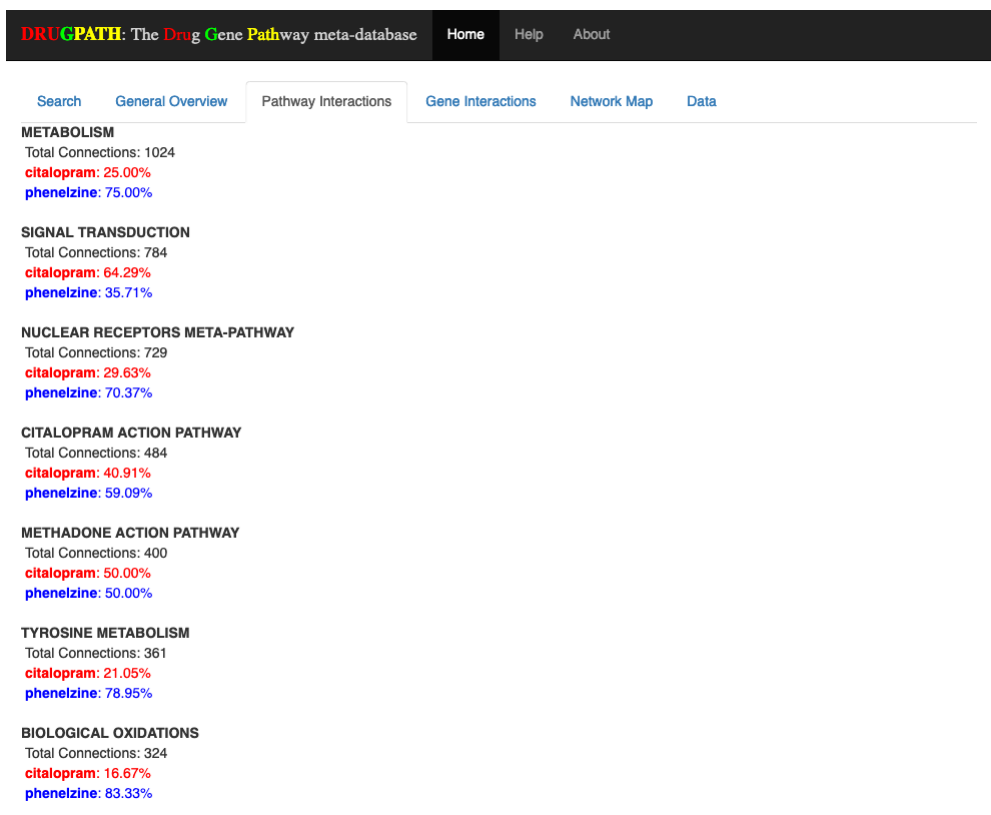
Figure 2. Pathway interactions between citalopram and phenelzine. Note that only the first few results are